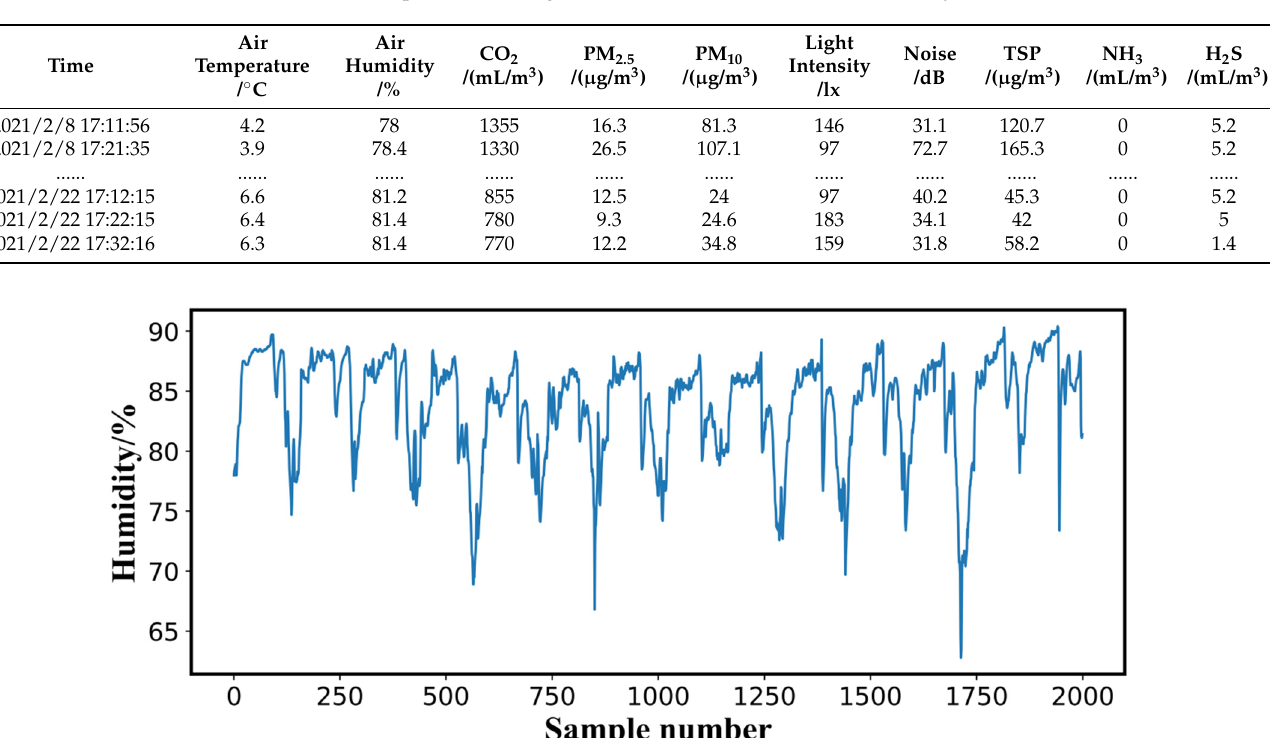
Figure 1. Schematic of the Xinjiang sheep house monitoring.